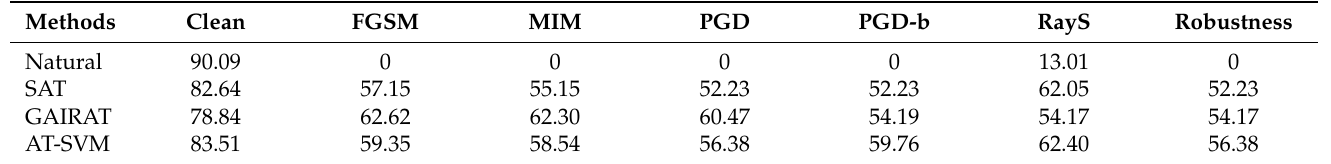
Table 1. Test accuracy of ResNet-18 on CIFAR-10